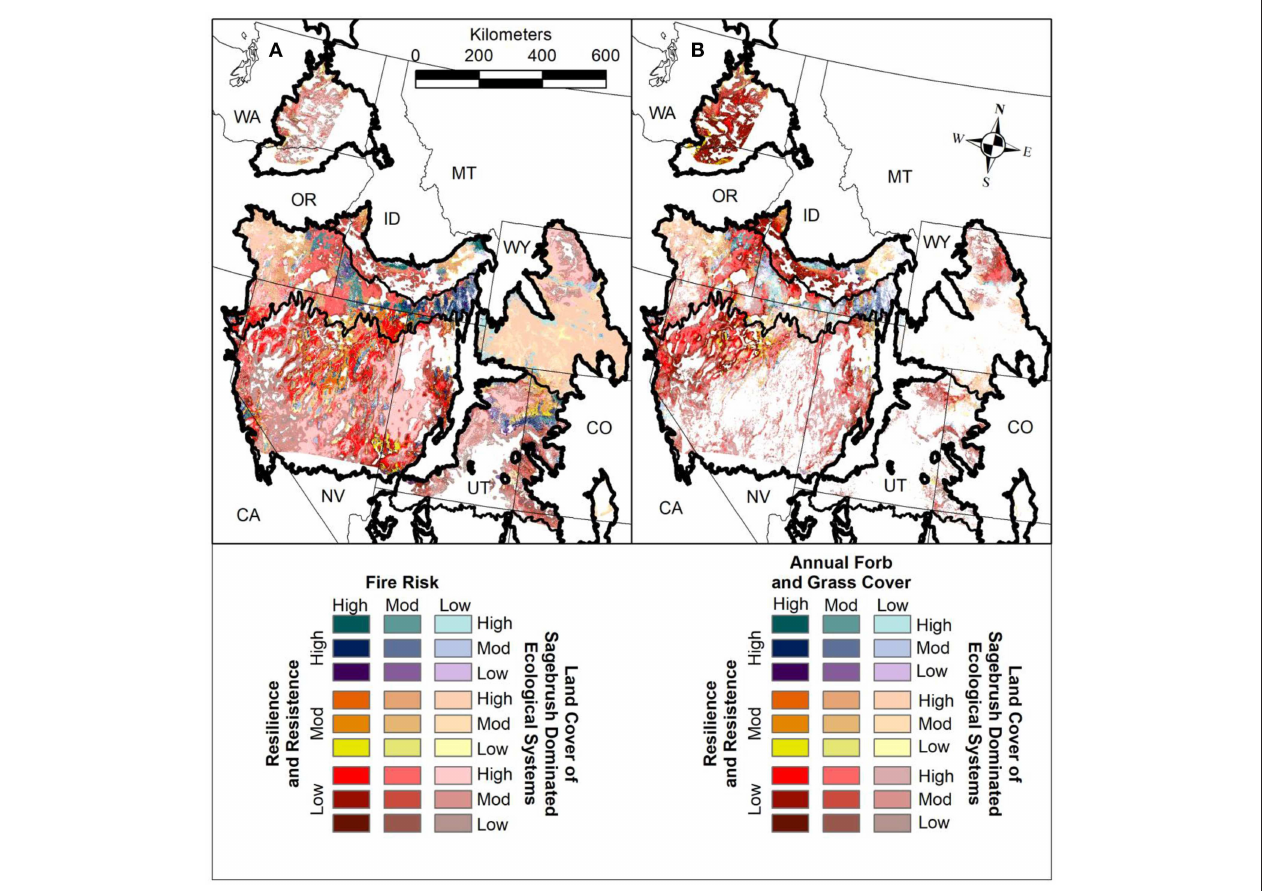
FIGURE 12 | (A) Map illustrating relative fire risk for sagebrush dominated ecosystems in the Cold Deserts. Large fire risk (U.S. Department of Agriculture, Forest Service [USDA FS], 2018) is intersected with resilience and resistance categories developed from soil temperature and moisture regimes (Maestas et al., 2016; Chambers et al., 2017a), and landscape cover of sagebrush categories (low = < 25%, moderate = 25–65%, high = > 65%) based on ecological minimum requirements underlying sage-grouse distributions (Knick et al., 2013; Chambers et al., 2014c). (B) Map of annual forb and grass risk for sagebrush dominated ecosystems in the Cold Deserts. Continuous land cover of annual forbs and grasses (low = 10–20%; moderate = 20–40%; high = > 40%) (Jones et al., 2018) is intersected with resilience and resistance categories developed from soil temperature and moisture regimes (Maestas et al., 2016; Chambers et al., 2017a) and landscape cover of sagebrush categories based on ecological minimum requirements underlying sage-grouse distributions (Knick et al., 2013; Chambers et al., 2014c).